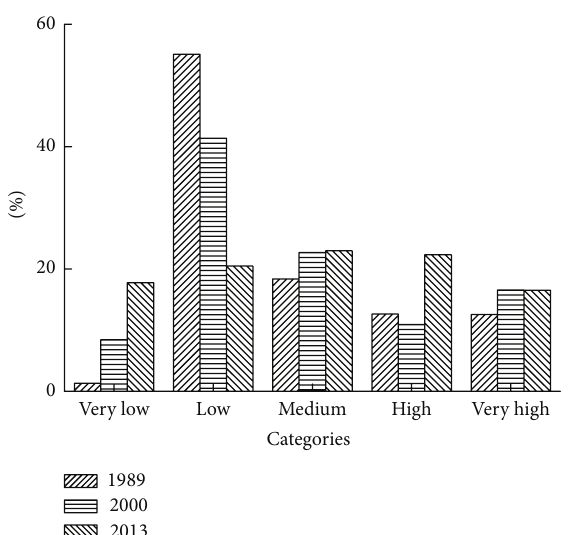
Figure 3: The histogram of the land area in each LST class.